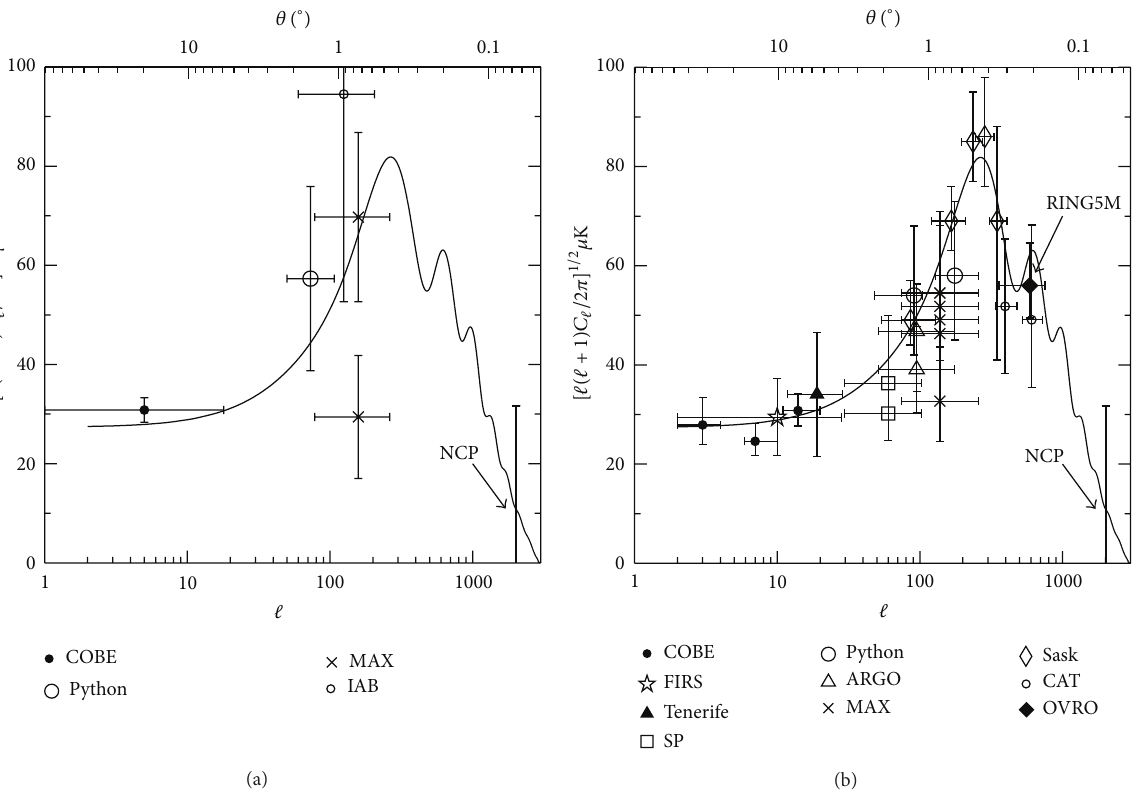
Figure 1: (Reproduced from [22]) (a) The state of CMB anisotropy detections in 1993. The points are from COBE [15], Python [17], MAX [18] and IAB [19]. Also shown is the upper limit from the OVRO NCP experiment [21]. (b) The state of the field in early 1998. Shown are COBE [36], FIRS [37], Tenerife [38], SP94 [39], Python [40], ARGO [41], MAX [42], Saskatoon [24], CAT [25], and the OVRO RING5M [23]. (The solid line is a CDM model with 𝐻 0 = 30 , Ω 0 = 1 and Ω 𝑏 = 0.05 , and is also indicative of the state of late 20th century